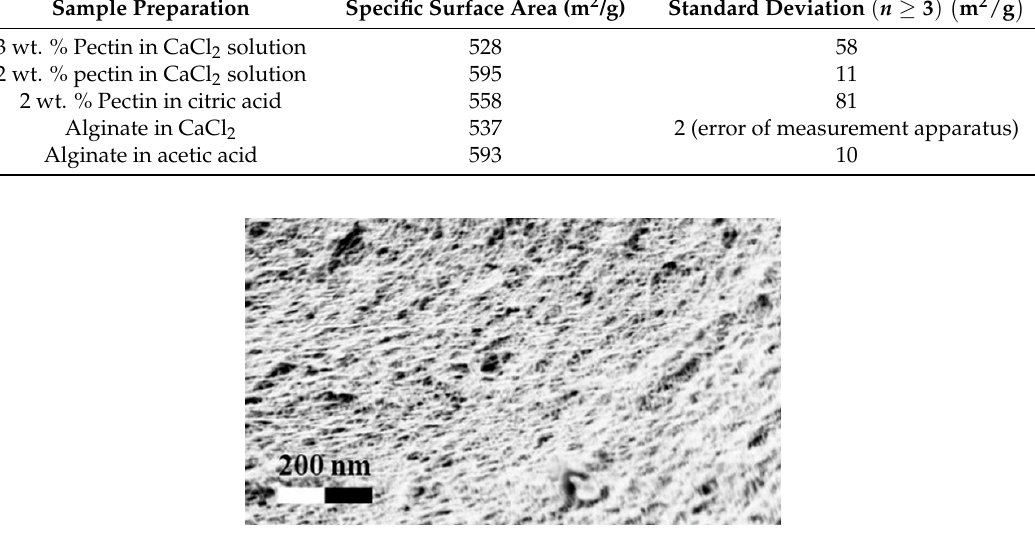
Figure 4. Inner structure of pure pectin aerogel produced via the diffusion method.